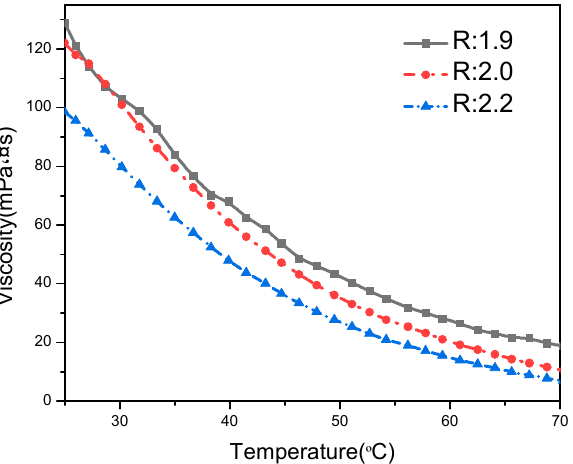
Figure 4. FT-IR spectra of real-time detection of polyurethane prepolymer.